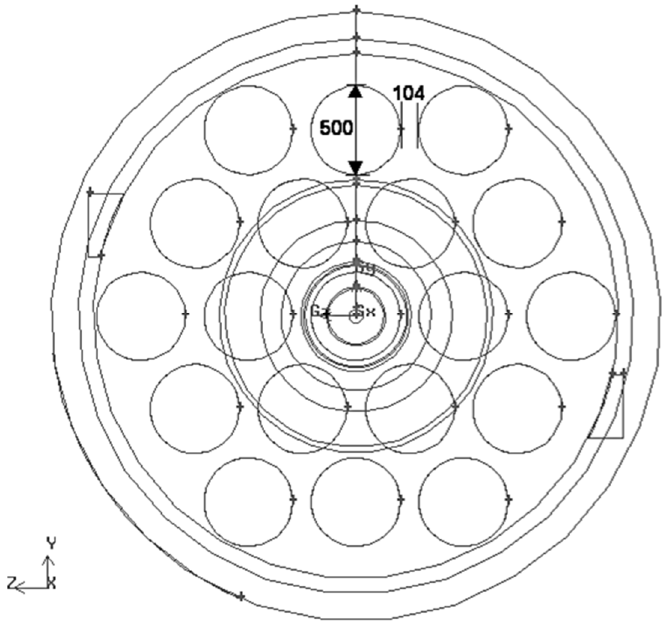
Figure 2. The numerical model for the SRU thermal reactor investigated.